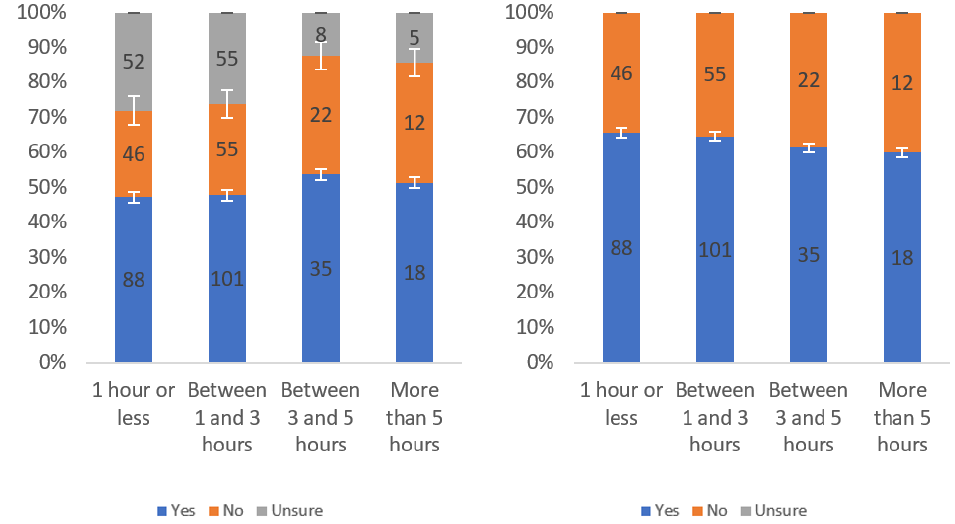
Figure 50. Responses regarding others’ willingness to review by internet usage level including ( left ) and excluding ( right ) unsure responses.